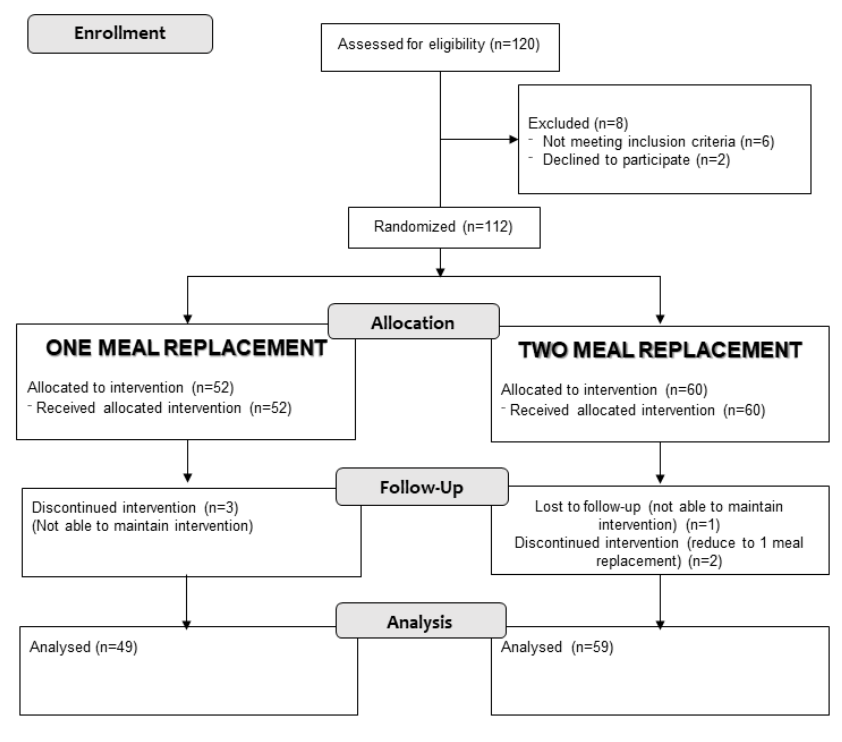
Figure 1. Flowchart. Table 2. Epidemiological variables, anthropometry, body composition, and cardiovascular risk factors before the intervention.